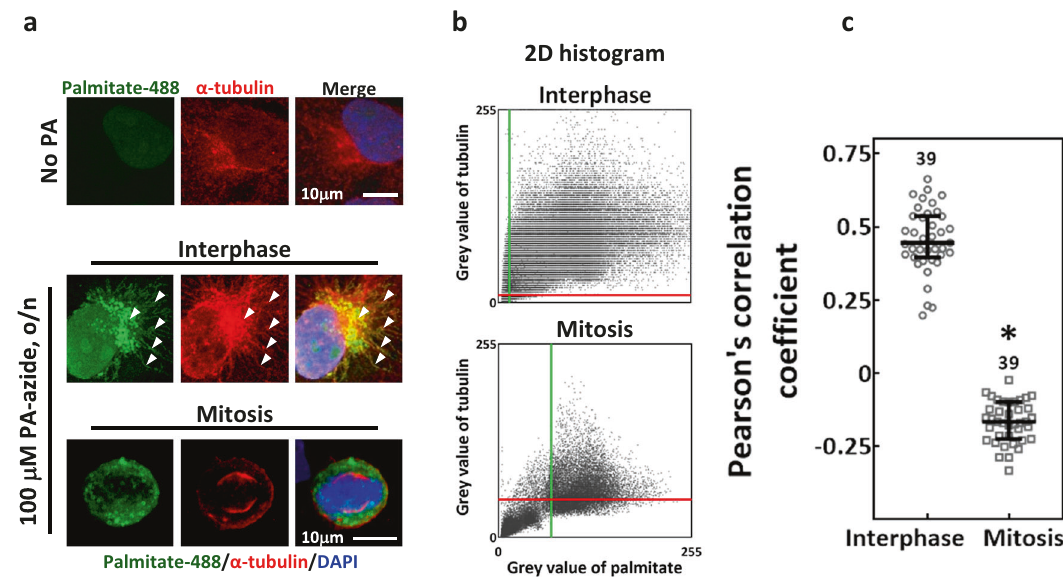
Fig. 4 Colocalization of palmitoylated proteins with α -tubulin. CGL2 cells were incubated with PA-azide overnight and subjected to click chemistry-mediated conjugation of AlexaFluor-488 to the palmitoyl-proteins. Cells without PA-azide incubation (No PA) served as the control. a Representative images show control cells (No PA) and the subcellular distribution of palmitoylated proteins (palmitate-488, green) in interphase and mitotic cells that were co-stained for α -tubulin (red) and DAPI (blue). The arrowheads indicate regions of colocalization between palmitate and α -tubulin. b The 2D histograms show the distributions of pixel intensities for α -tubulin and of palmitate in the corresponding representative images of interphase and mitotic cells shown in ( a ). The red and green lines indicate the intensity thresholds set for tubulin and palmitate, respectively. c The level of palmitate- α -tubulin colocalization was assayed by Pearson ’ s correlation coef fi cient. The coef fi cient calculations indicate a signi fi cantly lower level of colocalization in mitosis than in interphase. The numbers above indicate the number of cells assayed from two independent experiments. * P < 0.05 by Mann – Whitney rank-sum